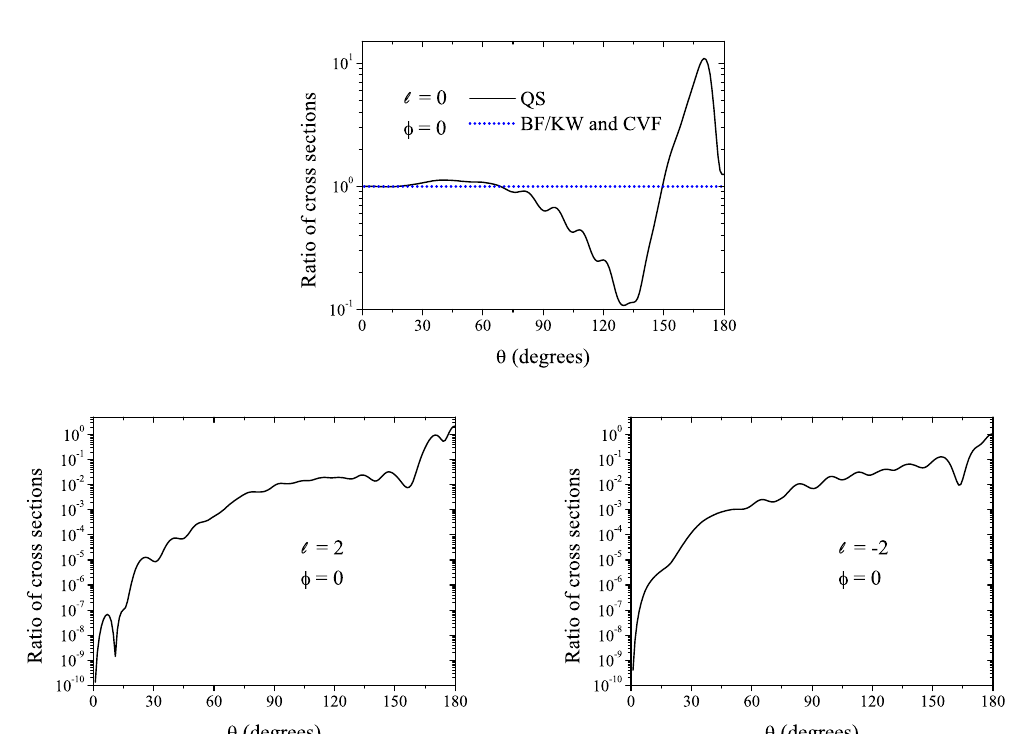
Figure 2. The ratio of differential cross sections (22) for photon numbers (cid:96) = 0, ± 2 when the laser polarization vector is perpendicular to the scattering plane ( φ = 0). The numerical results obtained using our QS approach are compared with those using the Bunkin–Fedorov and Kroll–Watson approximations (BF/KW) and the Coulomb–Volkov function (CVF), Equations (23) and (24)